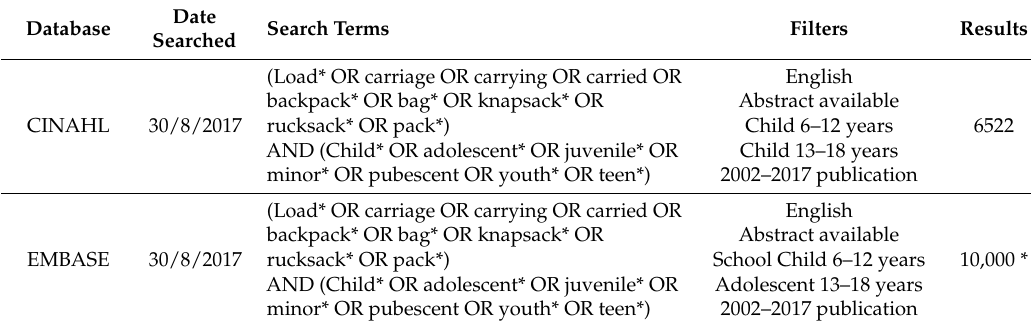
Table 1. Keywords, search terms and filters used in the literature search, by